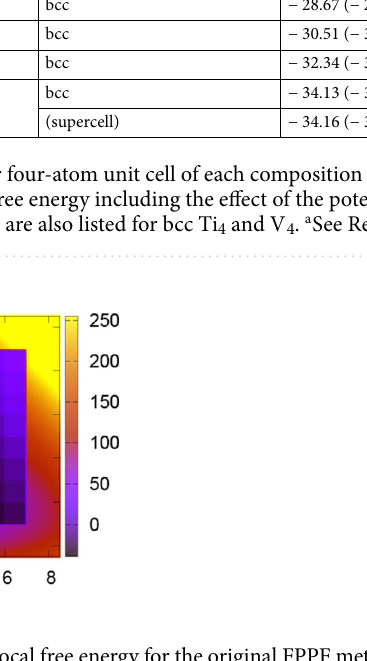
Figure 2. 2D map of the local free energy for the original FPPF method. The color scale is in units of eV.